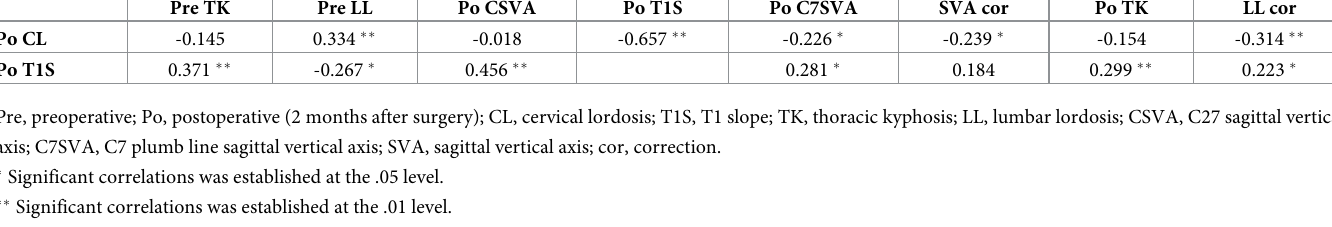
Last CL correlated with Last T1S and Last TK (p < .05). Last T1S correlated with Post TK, Post LL, Last CL and Last TK (p < .05). Last TK correlated with Post TK, Post LL, Post PI-LL, Last PT and Last T1S (p < .05). Multilinear regression analysis of these correlation factors allowed identification of the influencing factors significantly related to the Last CL (r = .439), Last T1S (r = .410) and Last TK (r = .418). After confirming the significance of each path, it was confirmed that the effect of Last T1S was significantly associated with the Last CL (p < .05). The unstandardized ß Table 3. Correlations between postoperative cervical lordosis, T1 slope, and other radiographic parameters. Pre